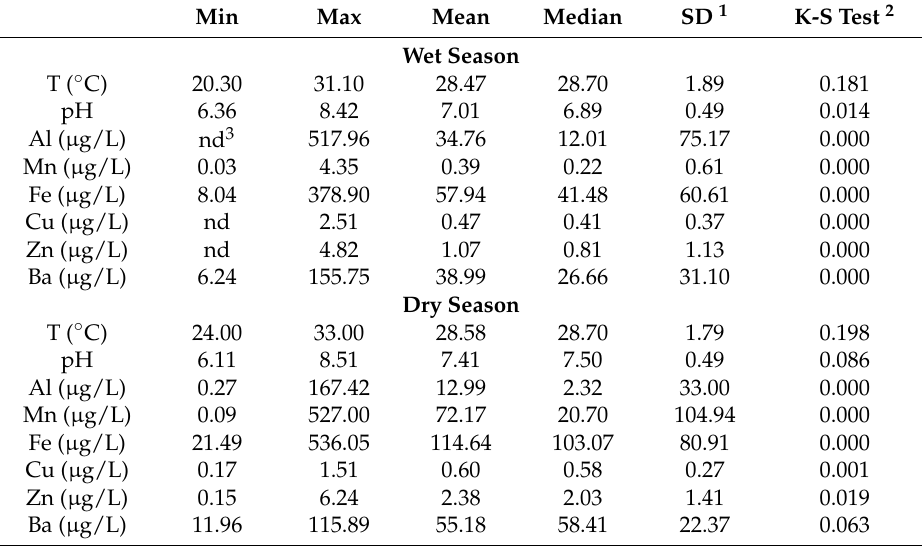
Table 1. Physicochemical parameters and concentrations of dissolved heavy metals in the Mun River. Min Max Mean SD